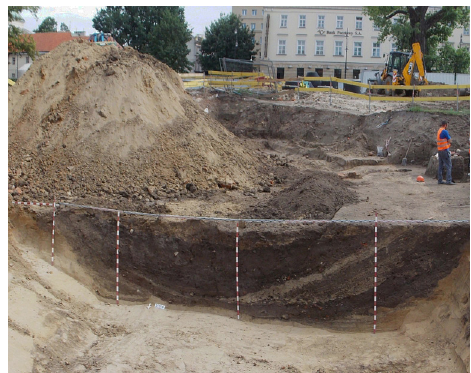
Fig. 5. A moat uncovered during archaeological